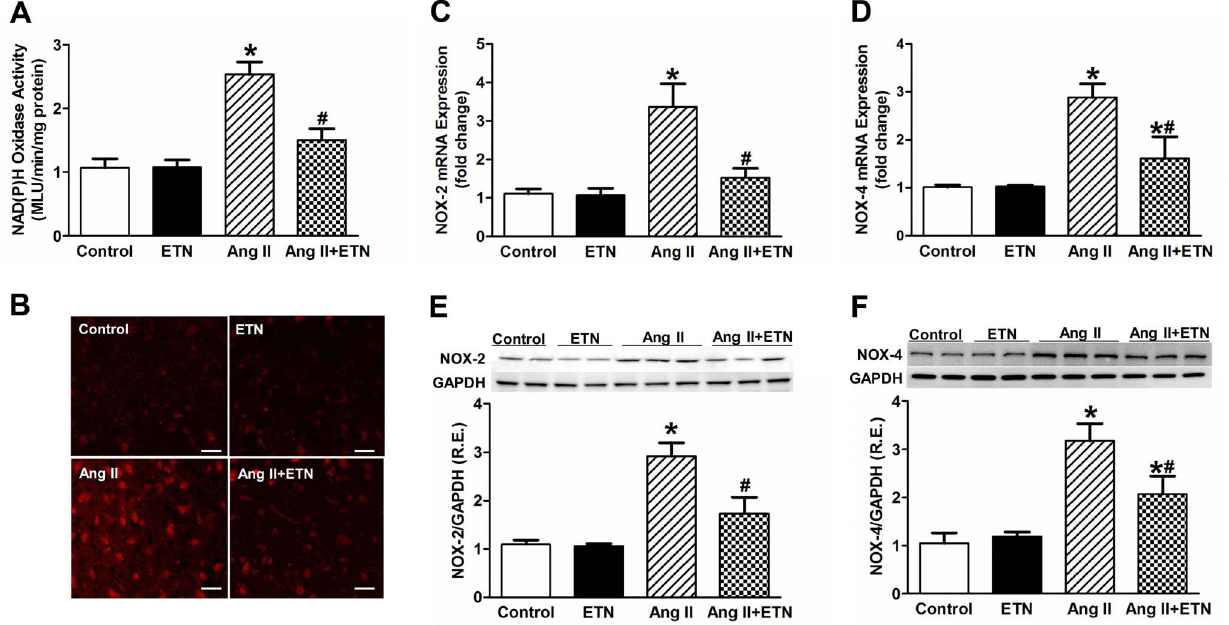
Figure 5. Effect of central TNF blockade on oxidative stress markers in the PVN. Ang II-infused rats demonstrated an increase in the NAD(P)H oxidase activity ( A ) and superoxide production ( B ) in the PVN compared with vehicle treated rats. These increases were reduced by TNF blockade with etanercept following Ang II infusion. Also, brain targeted TNF blockade significantly reduced Ang II-induced NOX-2 and NOX-4 mRNA ( C and D ) and protein ( E and F ) expression in the PVN. R.E. Relative expression, n=8–12 per group, * p , 0.05 vs Control, # p , 0.05 vs Ang II.